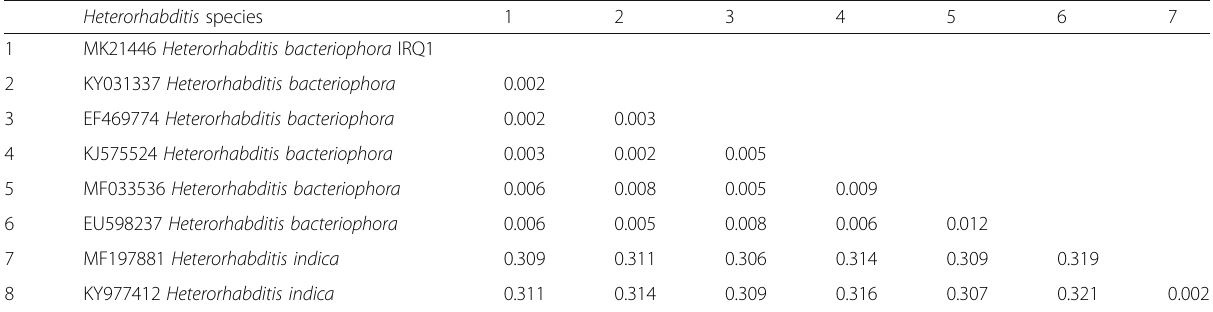
Table 1 Pairwise comparison on the number of nucleotide differences among some of Heterorhabditis species and isolates with Heterorhabditis bacteriophora isolate IRQ.1 based on ITS rDNA sequences Heterorhabditis species